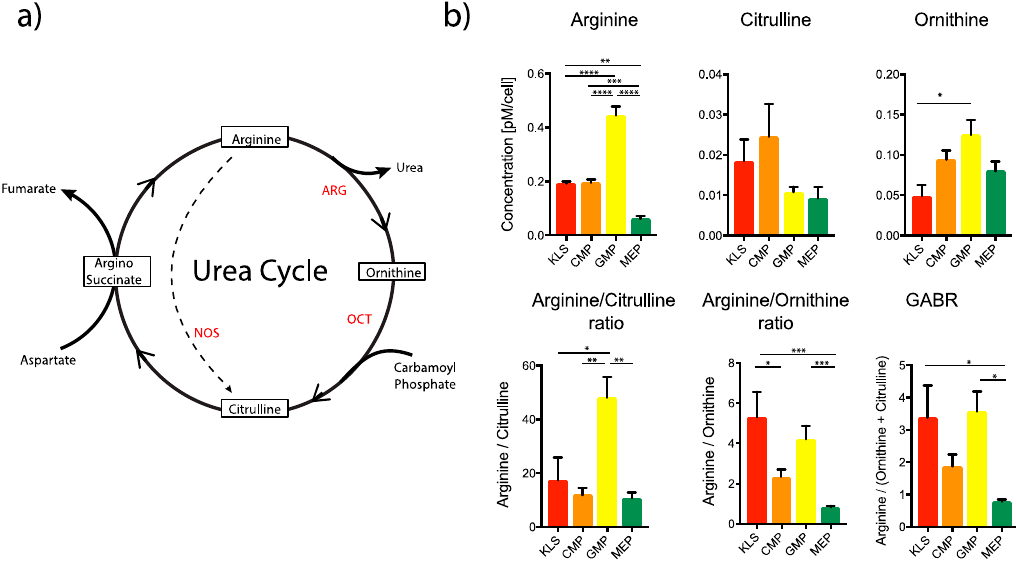
Figure 2. Estimation of Urea cycle intermediates in various bone marrow populations. ( a ) Schematic of the urea cycle. ARG: Arginase; OCT: Ornithine Carbamoyltransferase NOS: Nitric Oxide